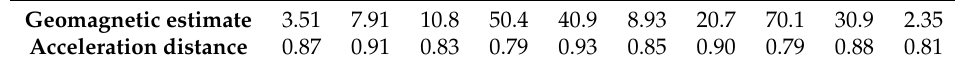
Table 4. Geomagnetic positions and associated